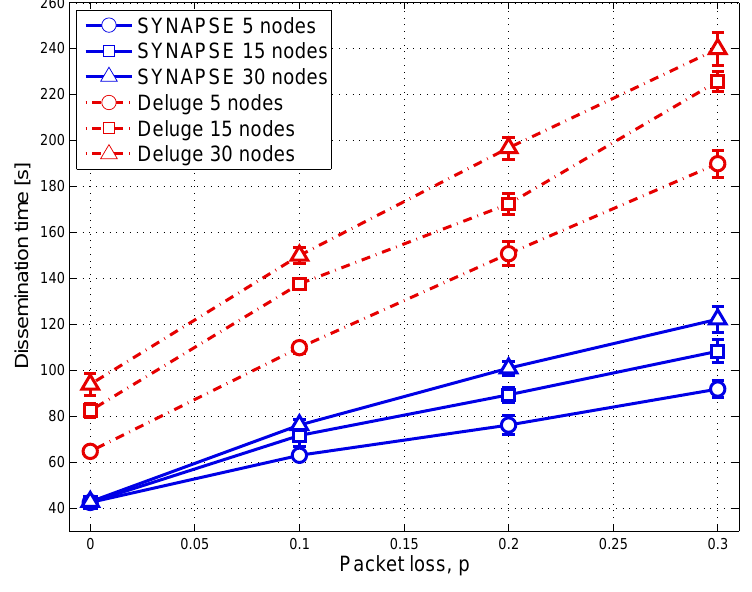
Figure 8. Program dissemination time as a function of the packet error rate p for an applica- tion of 27 , 100 bytes. Reproduced with permission from IEEE